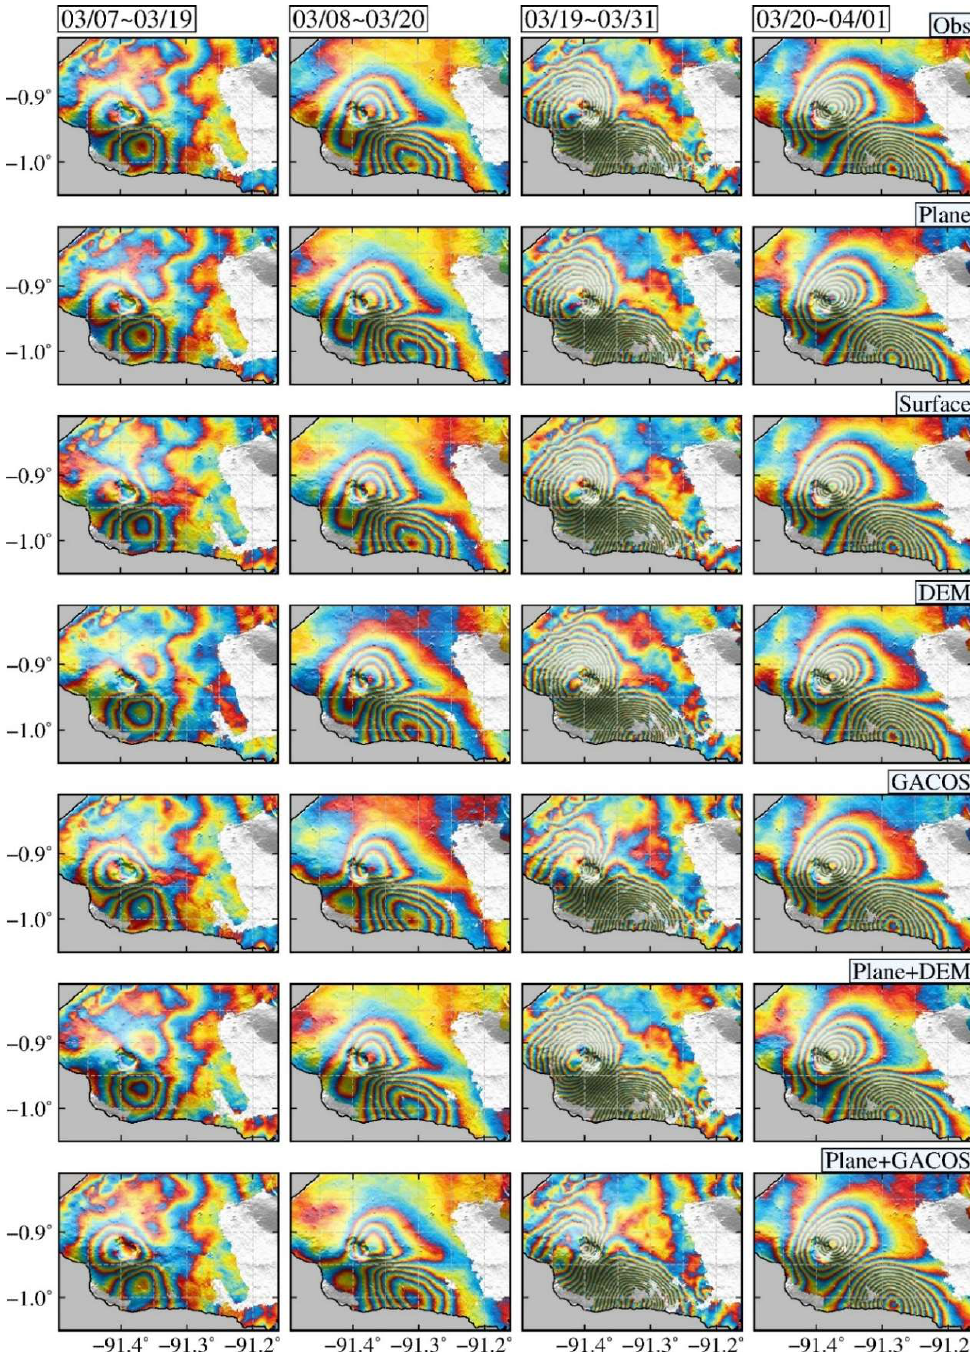
Figure A2. Six correction models with different combinations of parameters and coefficients removing the satellite orbit ramp and atmospheric delay from interferograms III–VI. Four columns represent four interferograms. Seven rows from top to bottom represent different correction models, which are: Obs: Observed data originally; Plane: Orbit ramp corrected by a plane; Surface: Orbit ramp corrected by a surface; DEM: Atmospheric delaying corrected by linear correlated with the digital elevation model (DEM); GACOS: Atmospheric delaying corrected by Generic Atmospheric Correction Online Service for InSAR (GACOS); Plane+DEM: Orbit ramp corrected by a plane and atmospheric delaying corrected by linear correlated with the DEM; and Plane+GACOS: Orbit ramp corrected by a plane and atmospheric delaying corrected by GACOS.